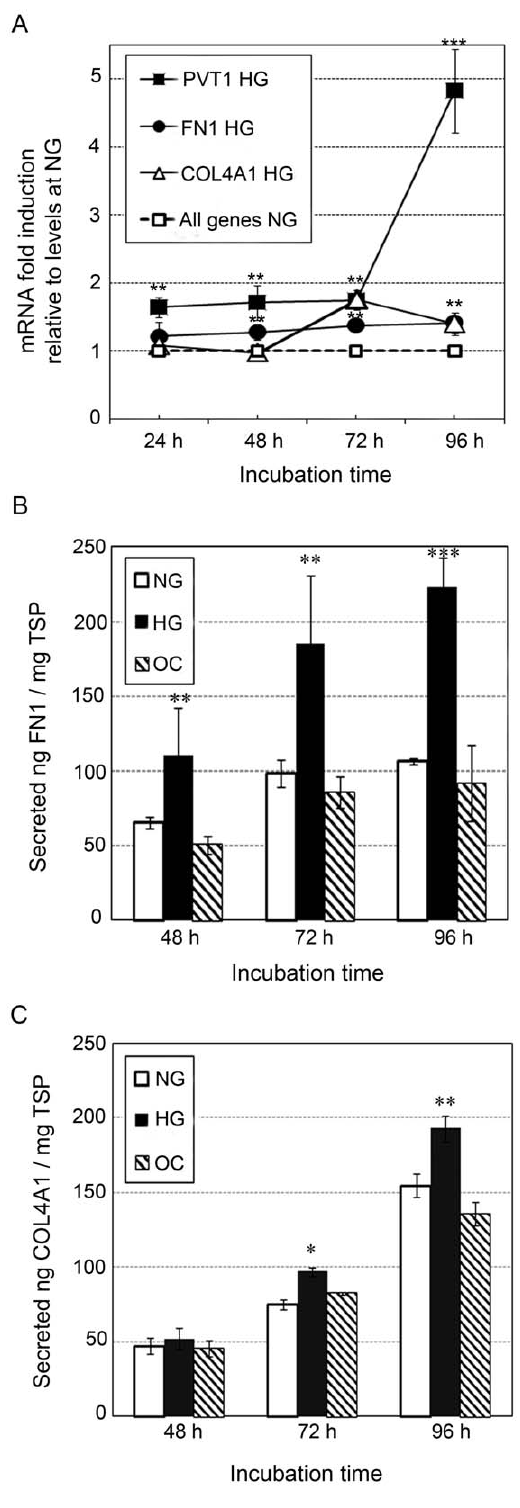
Figure 1. Effect of glucose on expression of PVT1 , FN1 , and COL4A1 in normal human mesangial cells (MC). Prior to treatment with high glucose, MC, at approximately 70% confluence, were cultured in serum-free MsBM medium for 24 hours to arrest and synchronize cell growth. After this time period, MC were grown for 24, 48, 72 or 96 h in MsBM medium supplemented with 5% FBS, containing either normal glucose (NG; 5.6 mM), NG + 3-O-methyl-D-glucose (3-O-MG) to control for osmotic effects (OC: 5.6 mM glucose + 24.4 mM 3-O-MG) or